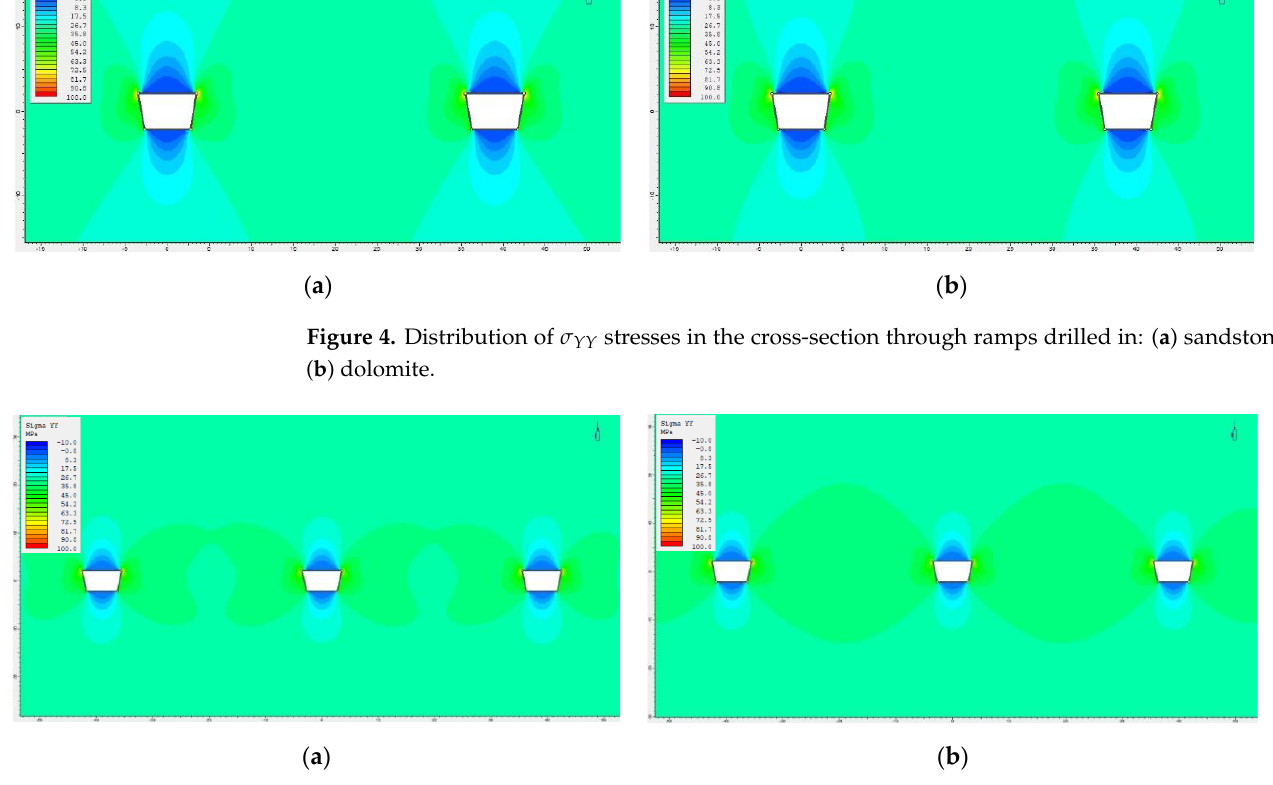
Figure 5. Distribution of σ YY stresses in the cross-section through entries drilled in: ( a ) sandstone; ( b ) dolomite.